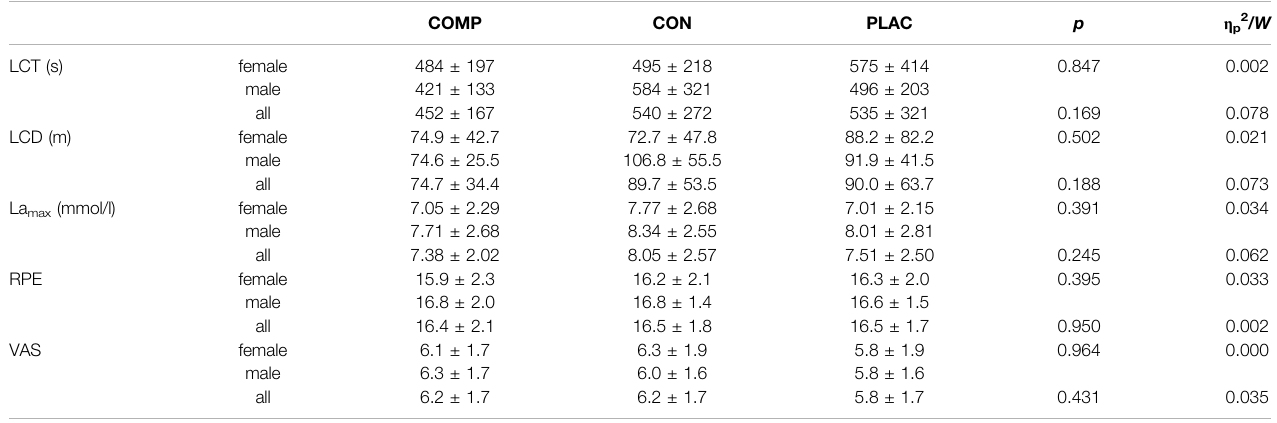
TABLE 5 | Lap climbing performance measurements of female ( n = 12), male ( n = 12), and all ( n = 24)